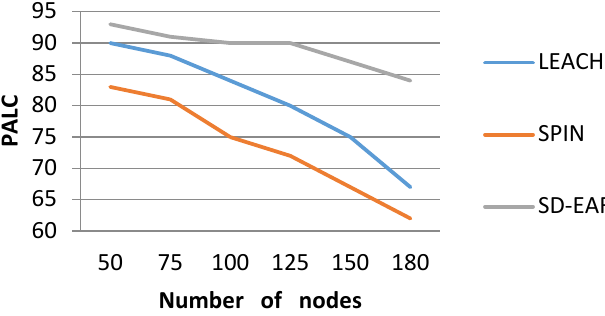
Figure 15. Percentage of alive nodes per established communication session (PALC) vs. number of nodes.